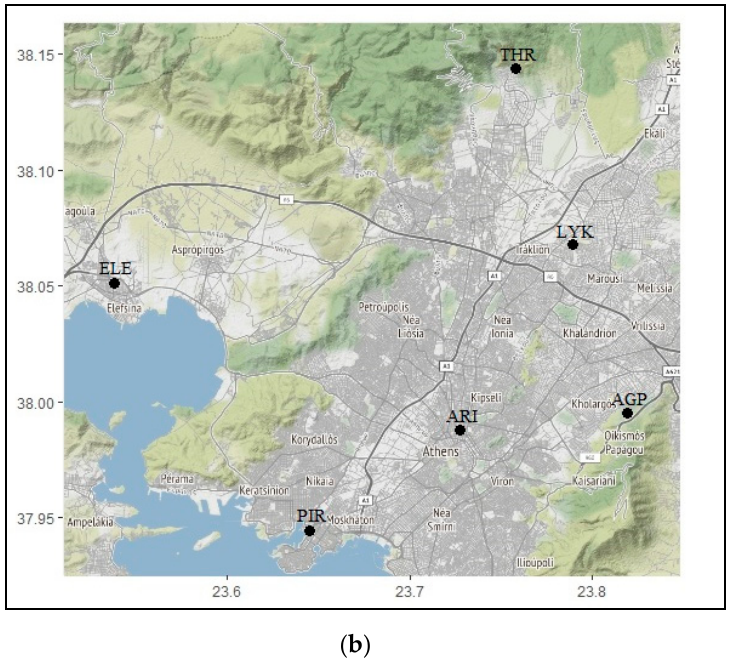
Figure 1. ( a ) Location map of Greece and ( b ) spatial coverage of the AQMS in Attica Region.